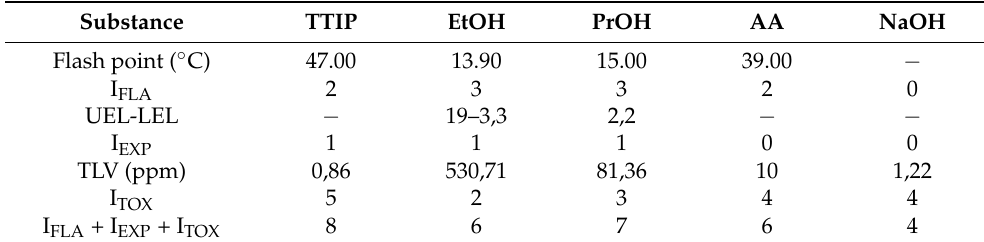
Table 4. Heat of reaction for the hydrolysis reaction.